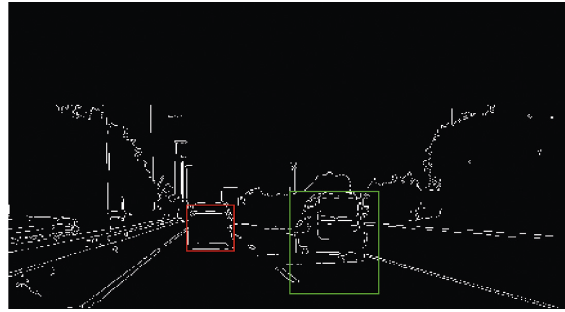
Figure 4: The result of the cross-correlation.